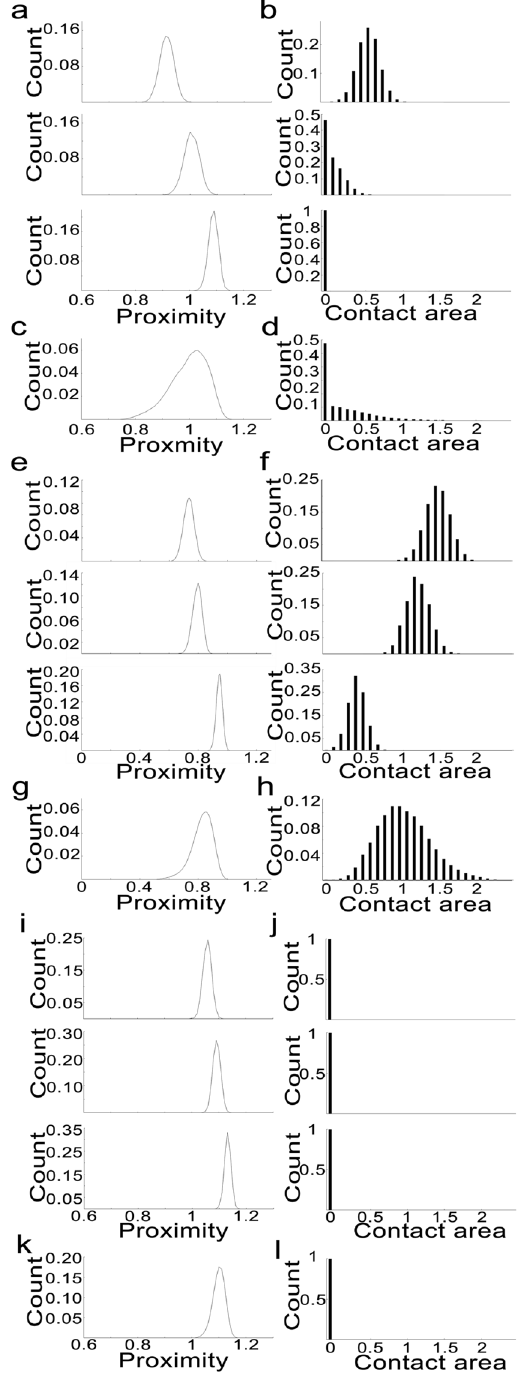
Figure 4. The histograms of the proximity of the center of each of the nine SVs as shown in Fig. 3, the histograms of their contact areas, and the histograms of the proximities and contact areas of 500 simulated SVs. ( a,e,i ) Histograms of the proximity of each of three different SVs having eight AZM connection sites randomly distributed on the surface of an SV’s hemisphere, upper half hemisphere, and lower half hemisphere, respectively as shown in Fig. 3. Note that the distribution of the AZM connection sites on the vesicle surface is related to the distribution of the proximity of the vesicle. ( b,f,j ) Histograms of the contact area of the vesicles. Note that the portion of undocked SVs having 0 contact area and the overall distribution of the contact area are also related to the distribution of the AZM connection sites on the vesicle surface. ( c,g,k ) Histograms of the proximities of 500 simulated SVs having eight AZM connection sites randomly distributed on the surface of each SV’s hemisphere, upper half hemisphere, and lower half hemisphere, respectively as shown in Fig. 3. ( d,h,l ) Histograms of the contact areas of the 500 simulated SVs having eight AZM connection sites randomly distributed on the surface of each SV’s hemisphere, upper half hemisphere, and lower half hemisphere, respectively as shown in Fig.